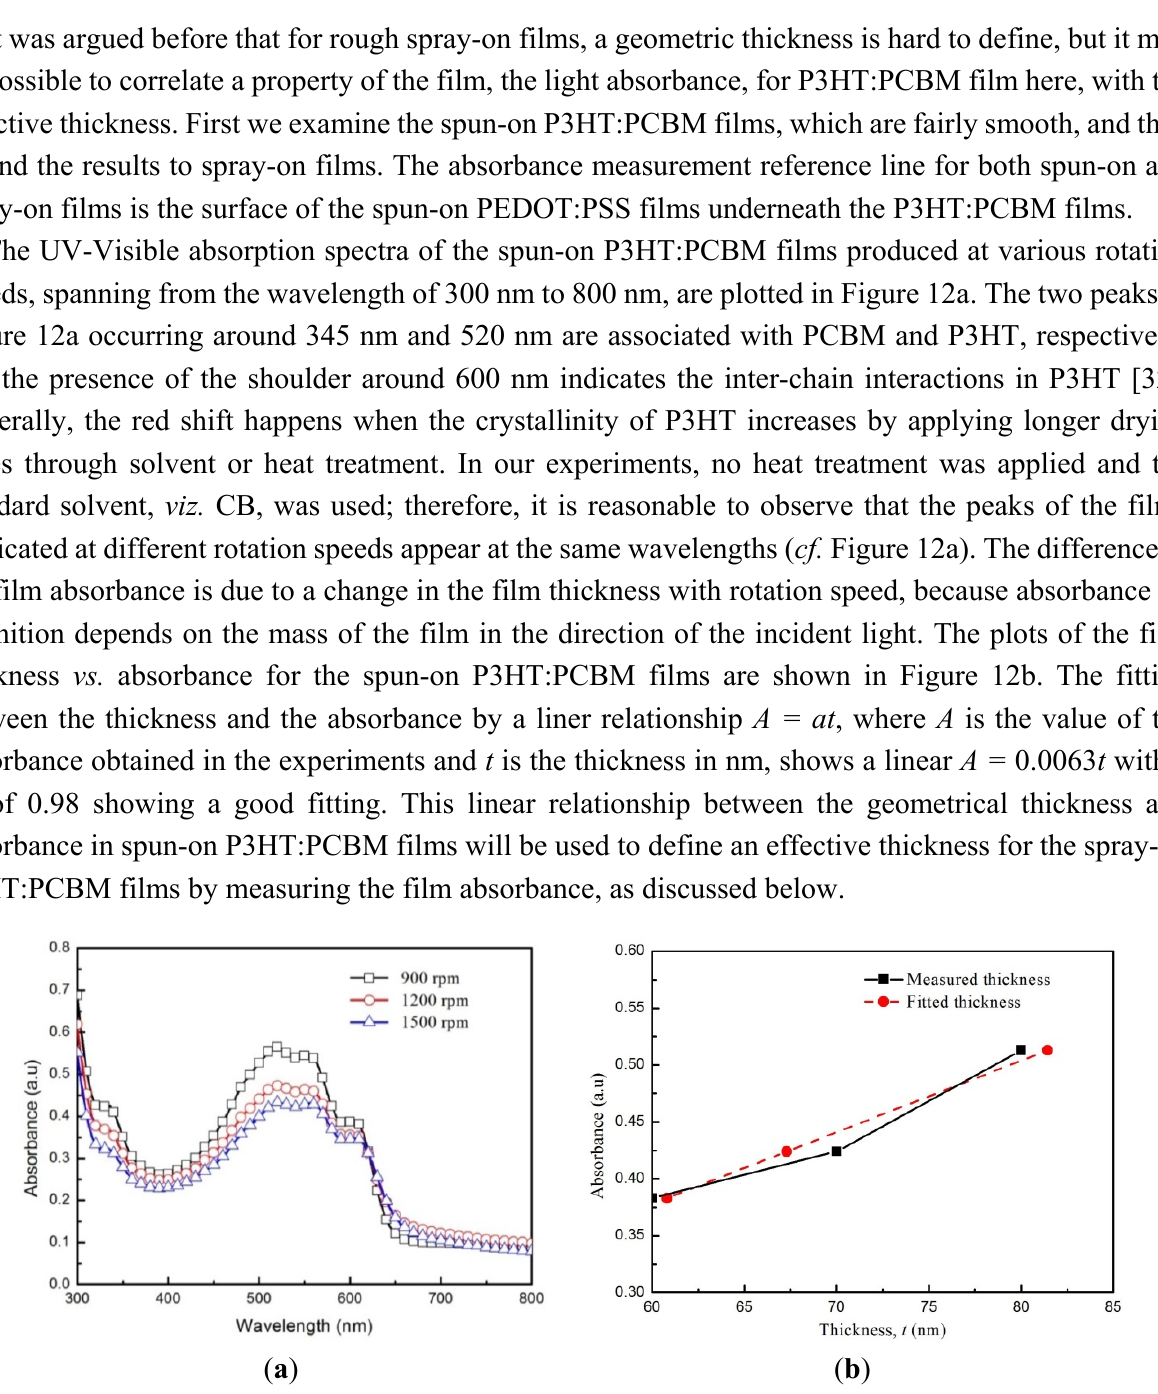
Figure 12. ( a ) UV-Visible absorbance of spun-on P3HT:PCBM films fabricated at different rotation speeds; ( b ) absorbance of spun-on P3HT:PCBM films versus film